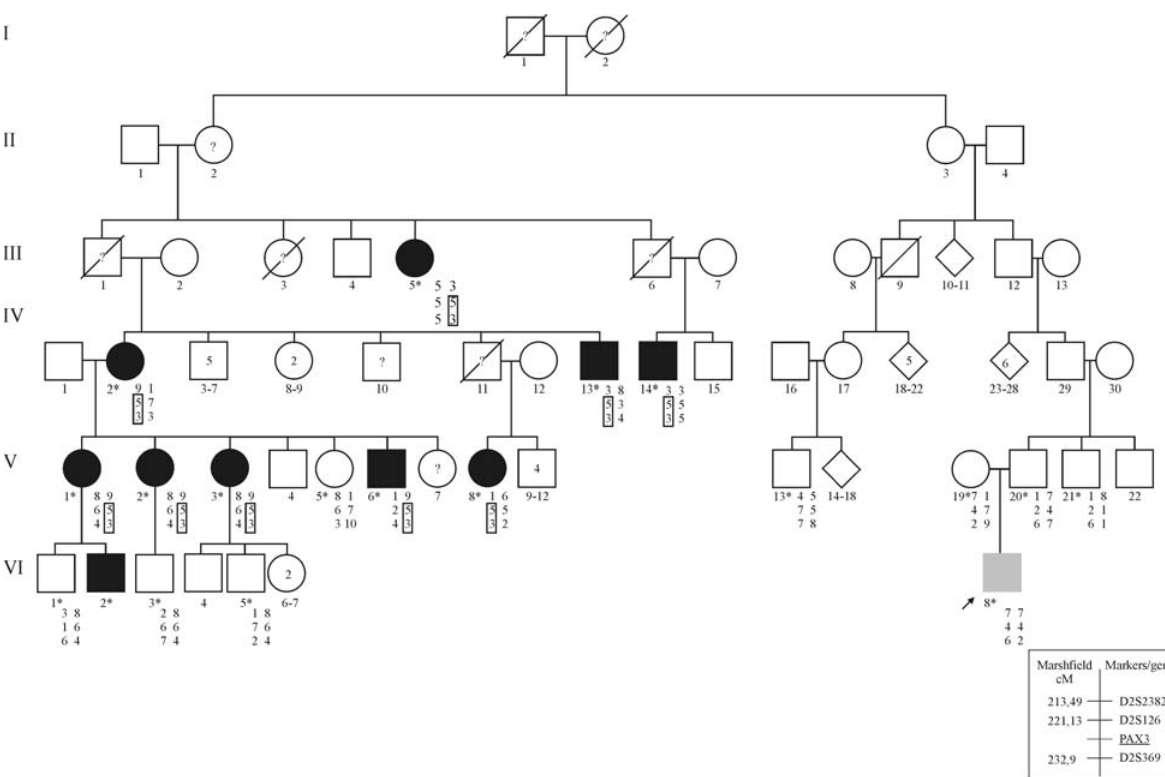
Figure 1 - Pedigree of Family 2. The boxed haplotype defined by markers D2S126 and D2S396 segregates with the WSI trait in the clinically evaluated family members. The proband, indicated in gray, is a deaf individual not affected by